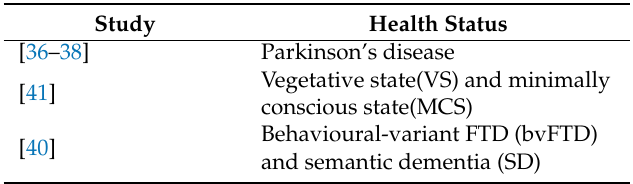
Table 2. Studies by participant types.